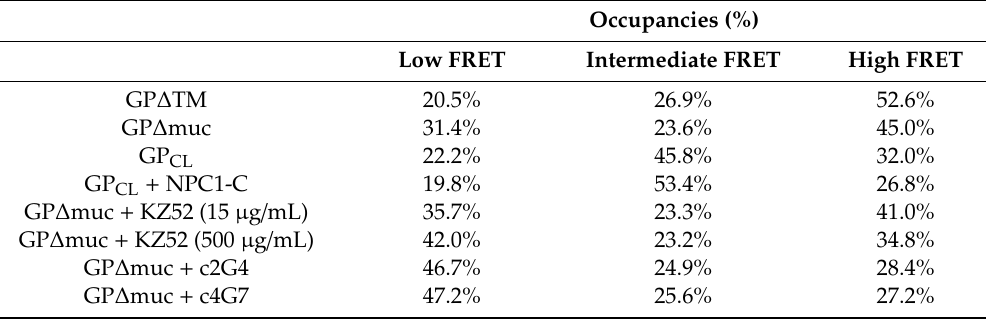
GP CL + NPC1-C GP ∆ muc + KZ52 (15 µ g / mL) GP ∆ muc + KZ52 (500 µ g /